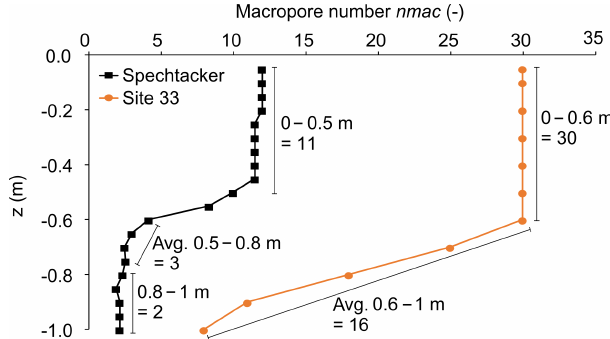
Figure 3. Distribution of macropore numbers with average diame- ters of 5mm (Spechtacker) and 6mm (site 33) along the vertical soil profiles at the two study sites. The arrows highlight the derivation of the macropore numbers at different depths (cf. Sect. 3.2), whereby “Avg.” means that at these depths the macropore numbers are aver- aged because there was no clear macropore pattern